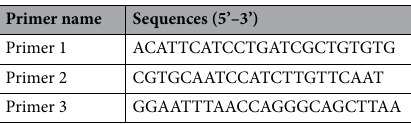
Table 1. Primers for genotyping PCR.